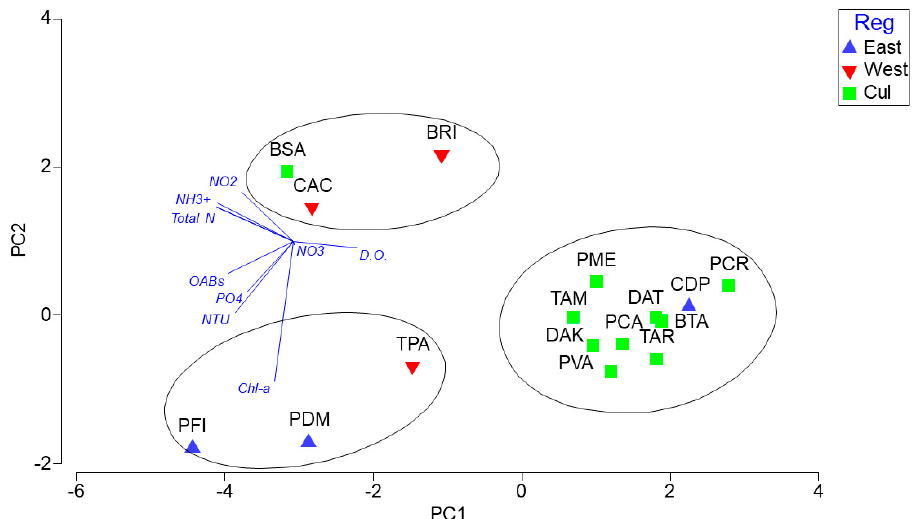
Figure 8. Principal components analysis (PCA) based on the log ( x +1) -transformed and normalized concentration of water quality parameters by region and location. This solution explains 74.1% of the observed spatial variation. Refer to the Methodology for the description of acronyms.